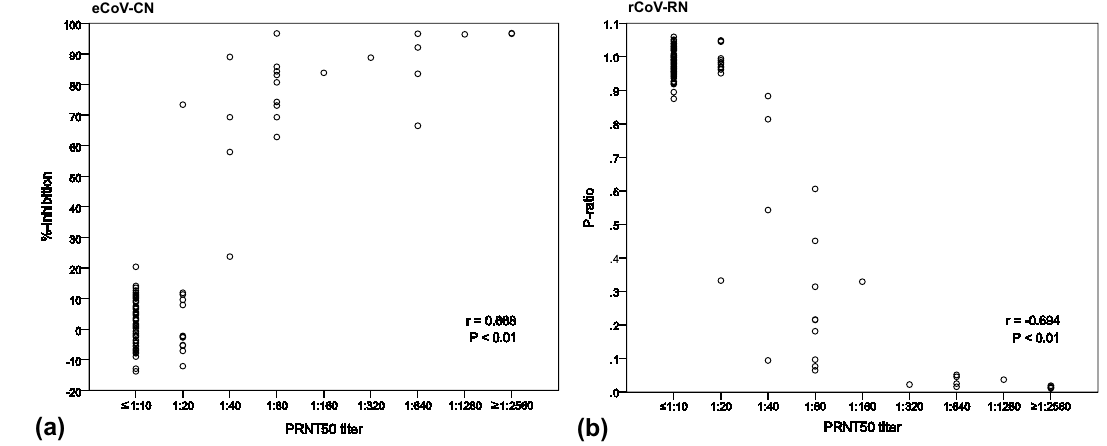
Figure 2. Correlation analysis between PRNT 50 titer and ( a ) %-inhibition values from VERI-Q SARS- CoV-2 Neutralizing Antibody Detection ELISA Kit (eCoV-CN) and ( b ) P -ratio from VERI-Q SARS-CoV-2 Neutralizing Antibody Rapid Test Kit (rCoV-RN), conducted using 105 sera, including 30 from the patients infected with SARS-CoV-2.